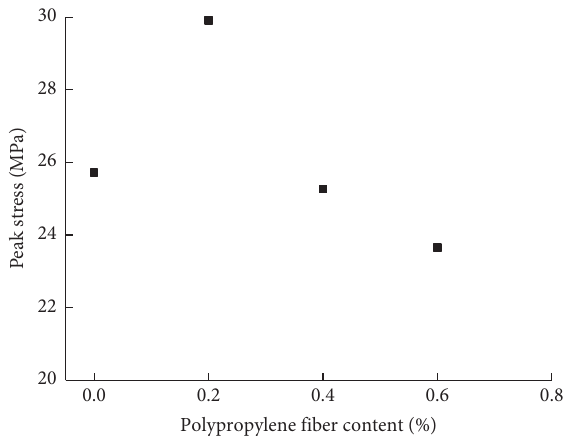
Figure 5: Relationship between polypropylene fiber content and peak stress.